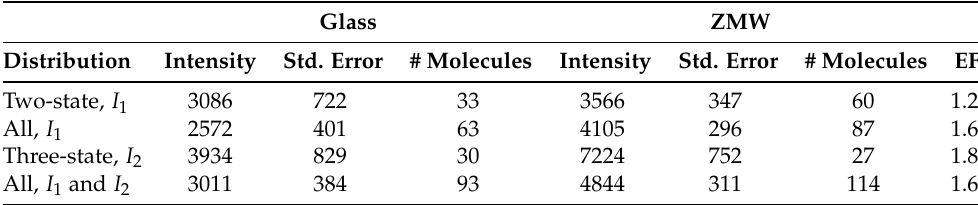
Table 1. Fluorescence emission